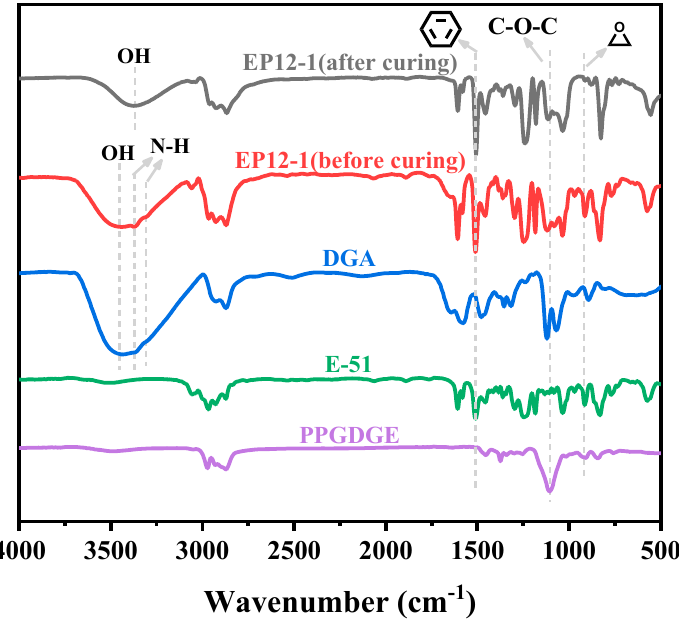
Figure 4. FTIR spectra of DGA, E-51, PPGDGE, and EP12-1 before and after curing.